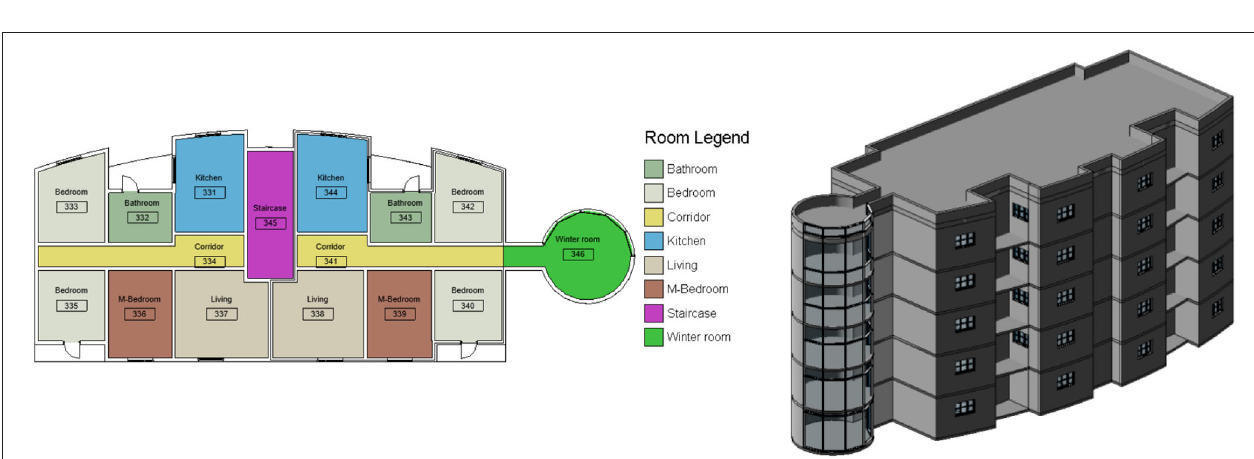
FIGURE 11 | The new building shape after being modified in